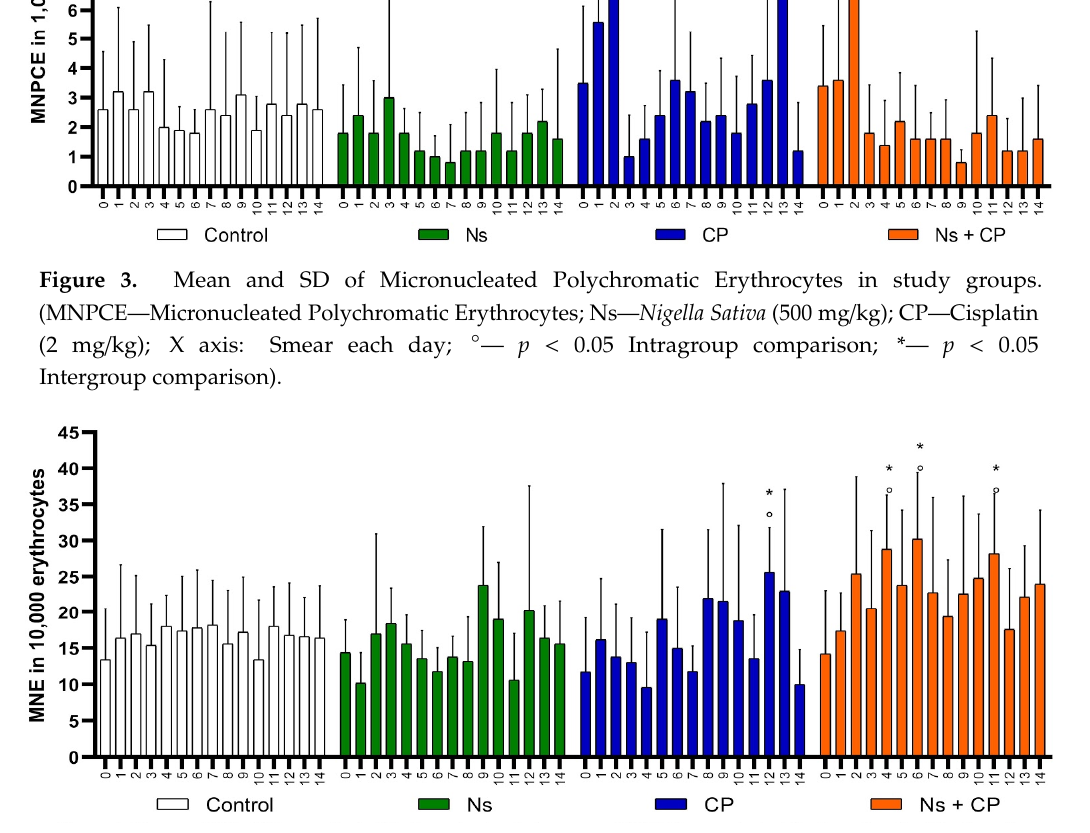
Figure 4. Mean and SD of Micronucleated Erythrocytes in study groups. (MNE-Micronucleated Erythrocytes; Ns- Nigella Sativa (500mg/kg); CP-Cisplatin (2mg/kg); X axis: Smear each day; °- p < 0.05 Erythrocytes; Ns— Nigella Sativa (500 mg / kg); CP-Cisplatin (2 mg / kg); X axis: Smear each day; ◦ — p < 0.05 Intragroup comparison; *— p < 0.05 Intergroup Intragroup comparison; *- p < 0.05 Intergroup comparison).